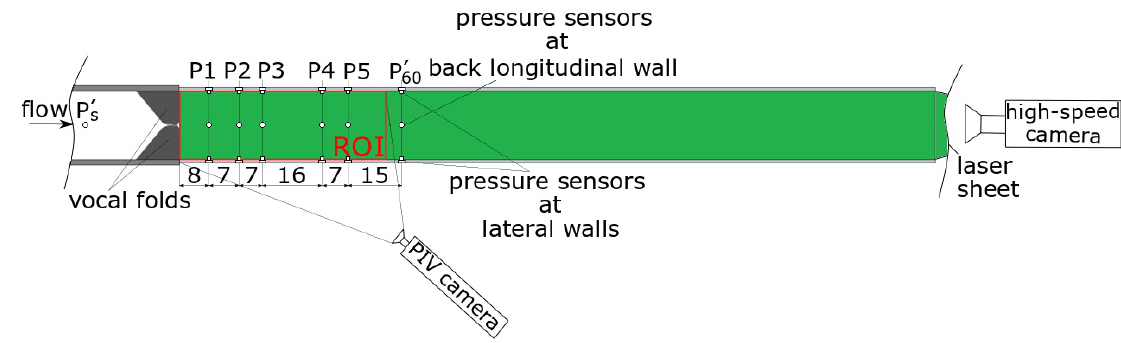
Figure 1. Schematic of the experimental larynx model with the locations of the pressure sensors and the ROI in the supraglottal channel for the PIV measurement. The high-speed camera downstream of the supraglottal exit recorded the motion of synthetic vocal folds from a superior view. All dimensions are in